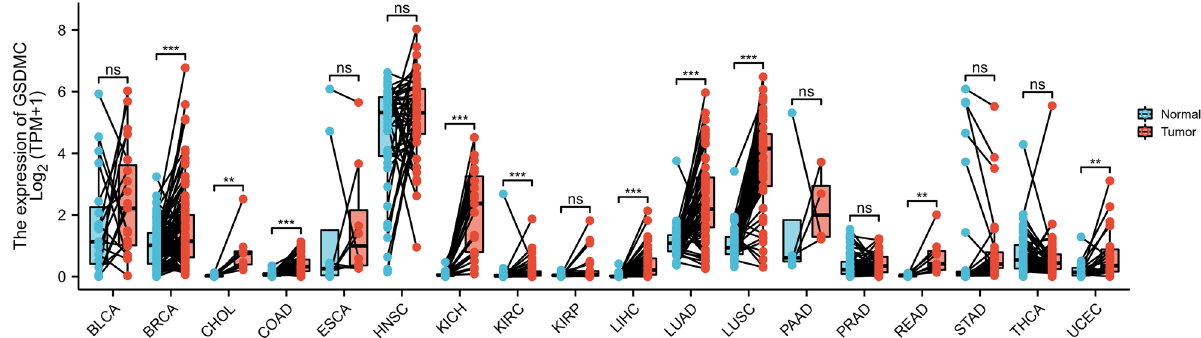
Figure 2. The transcription levels of GSDMC in different cancers from TGGA database. * P < 0.05, ** P < 0.01, *** P < 0.001.